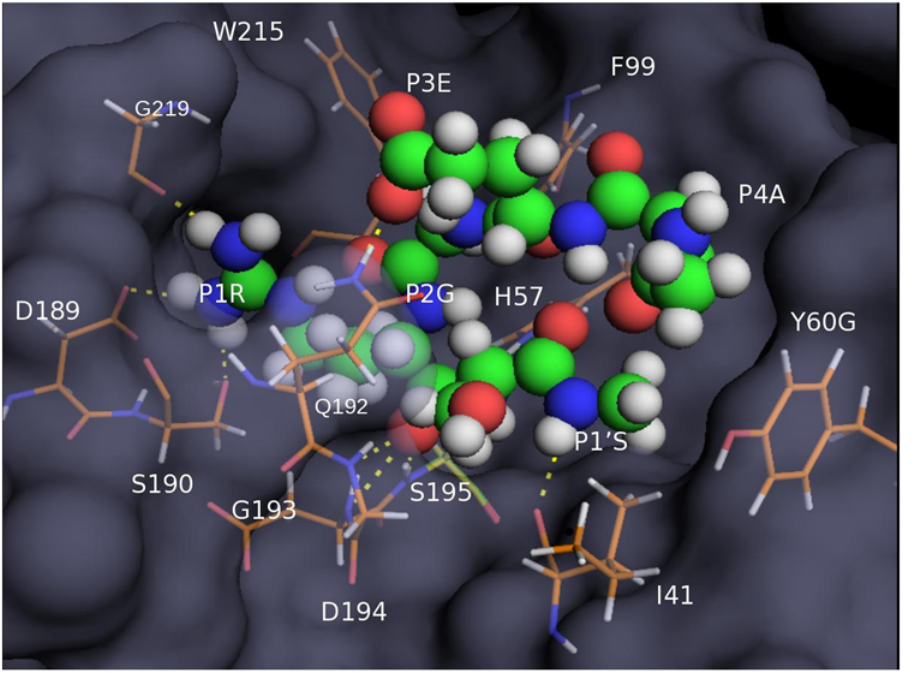
Figure 2. Structure of matriptase docked with a model peptide substrate. A) AEGRS (spheres) was docked to the matriptase structure (2GV6; light blue) using various components of Mastero (Schro¨dinger) as described under Text S1. Residues that are 4 A˚ distance from the ligand are shown as sticks. Polar interactions of the ligand with active site residues are indicated as dashes (yellow).